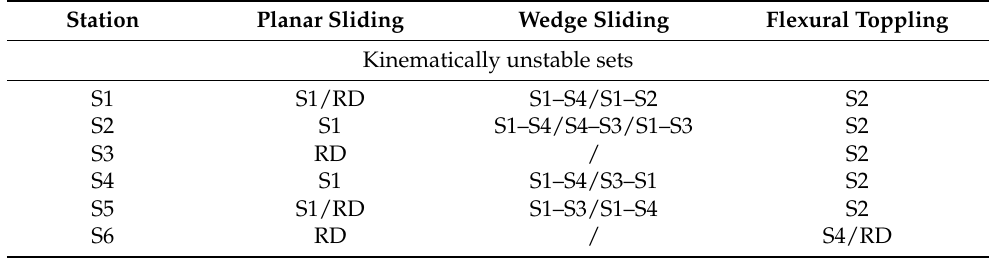
Table 3. Summary of the main unstable kinematic patterns at each surveying